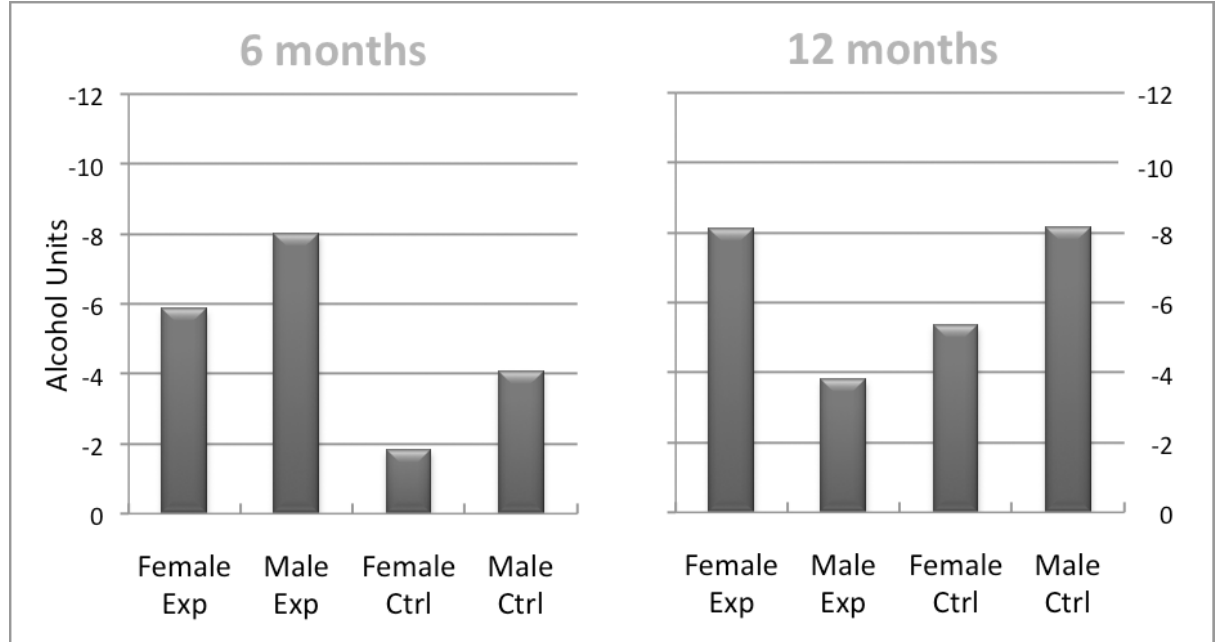
Figure 3. Reductions in mean weekly alcohol consumption (in mean weekly units containing 10 g of ethanol) in experimental and control groups 6 and 12 months after baseline, by gender (LOCF)